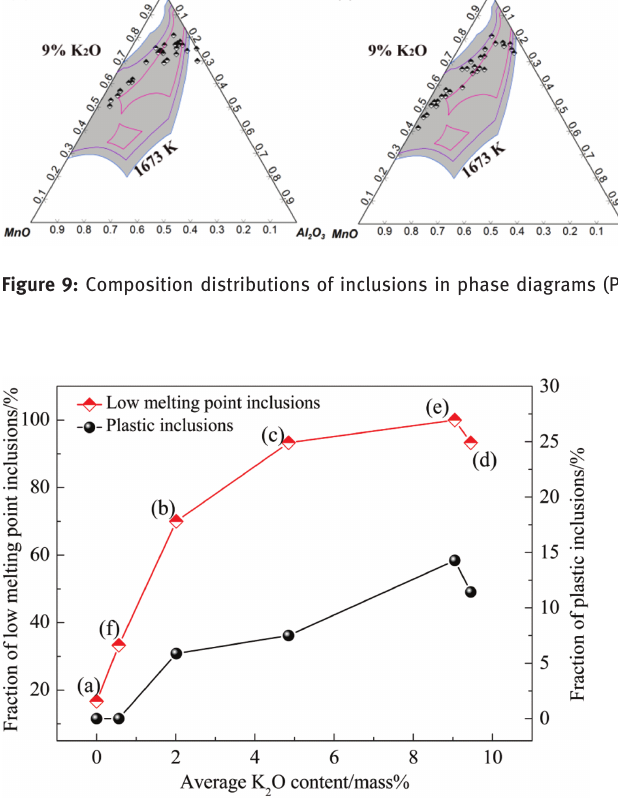
Figure 10: Effect of K 2 O content on the deformability and melting temperature of